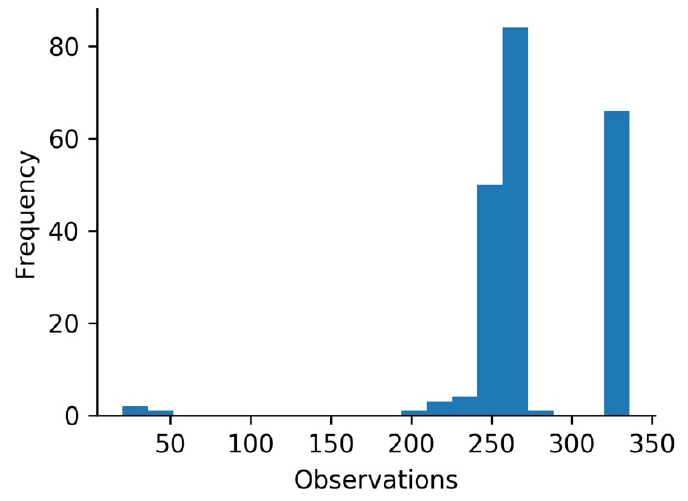
Figure 1. Histogram on the number of observations (dates with data) per country. The ECDC database also had some incorrect ISO 3166-1 alpha-3 country and territory codes [22] (variable countryterrritoryCode ), namely Namibia and Taiwan’s codes. While the first was missing, the second was coded as “CNG1925” instead of “TWN”. As shown in Table 3, apart from some outliers in the Gross National Income Per Cap- ita variable (for instance, the standard deviation portrays a larger number than the mean, which underlines significant levels of inequality among countries), no major data quality issues were found in the UNDP dataset used. Table 3. UNDP Dataset [21] Summary Statistics. Variable